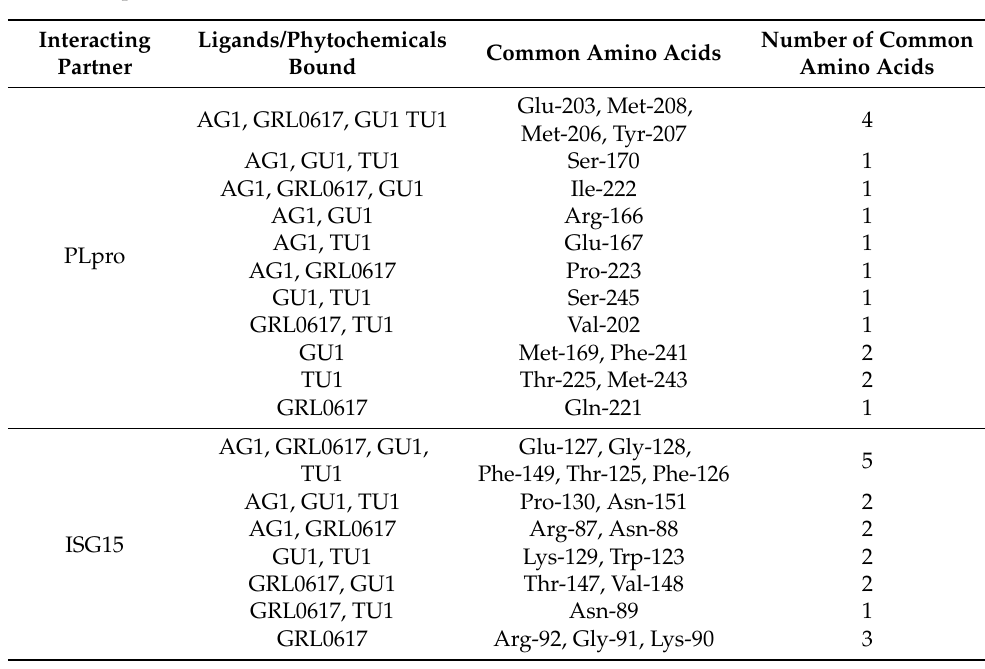
Figure 5. Binding energies (kJ/mol) at the individual amino acid levels were calculated for the average structure of the last 50 ns for each of the complexes. Key interacting residues from PLpro or ISG15 were considered for calculating binding energy for AG1 ( i ), GU1 ( ii ), TU1 ( iii ) and GRL0617 ( iv ) in each case. Table 2. Common amino acids engaged by different phytochemicals for binding to PLpro and ISG-15